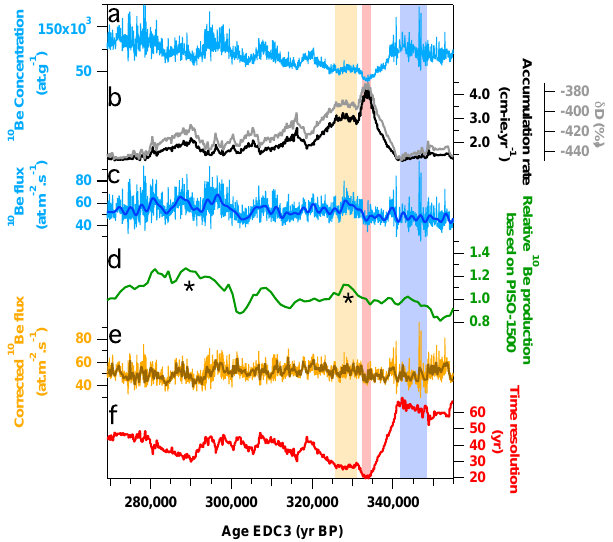
Figure 1. High-resolution 10 Be data between 2384 and 2627m deep (269–355ka on the EDC3 age scale). (a) Raw 10 Be concen- trations (atg − 1 ). (b) In grey, δD profile at EDC including the in- terglacial period MIS 9.3 (Jouzel et al., 2007). In black, the accu- mulation rate of the site (cmieyr − 1 ) (Parrenin et al., 2007b). The light-yellow and light-red areas show the plateau during MIS 9.3 at the same isotopic level than PI and the MIS 9.3 optimum warmer than PI. The light-blue area corresponds to the MIS 10 glacial max- imum just before the Termination IV. (c) Calculated 10 Be flux us- ing EDC3 accumulation rate. The light-blue curve corresponds to raw data, and the bold-blue curve is the low-pass-filtered 10 Be flux (1 / 2000yr − 1 ). (d) 10 Be production based on palaeointensity record PISO-1500 (Channell et al., 2009) on the EDC3 age scale and cal- culated using calculations of Masarik and Beer (2009). The as- terisks show the possible correlation with proposed geomagnetic events: the Portuguese Margin ( ∼ 290ka) and Calabrian Ridge 1 ( ∼ 320ka). (e) Raw and 100-year resampled 10 Be flux corrected by PISO-1500. (f) Time resolution of the 10 Be profile (difference between the n and n + 1 sample